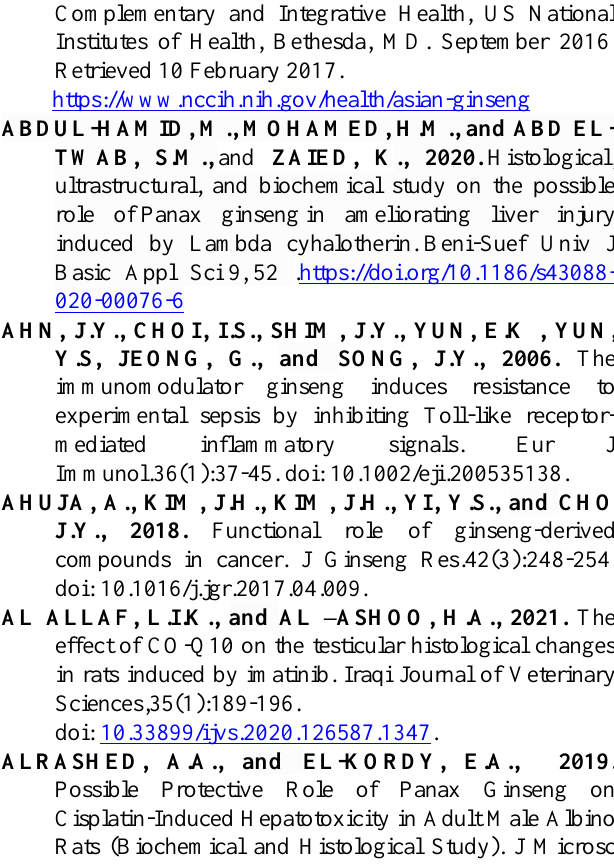
Fig. 2: Multifaceted actions of ginseng (Kim et al.,